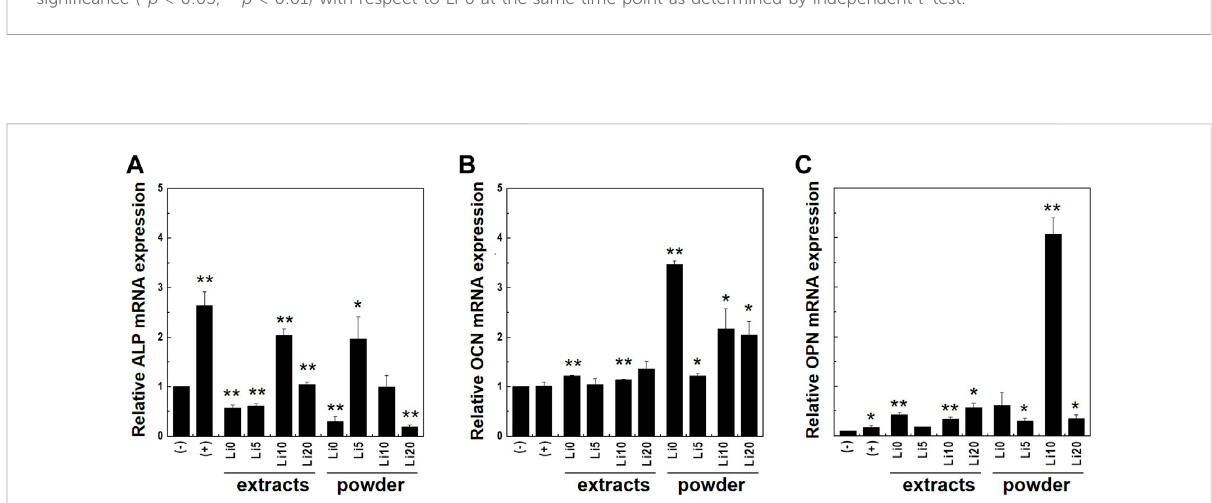
FIGURE 11 Expressionlevelsofosteo/odontogenicdifferentiationmarkers; (A) ALPand (B) OCN,and (C) OPNwereanalyzedwithreal-timePCR.Cellwere cultured both in full medium [(-)control] and ODM [(+)control]. Asterisks indicate statistical signi fi cance (* p < 0.05, ** p < 0.01) with respect to (-) control at the same time point as determined by independent t